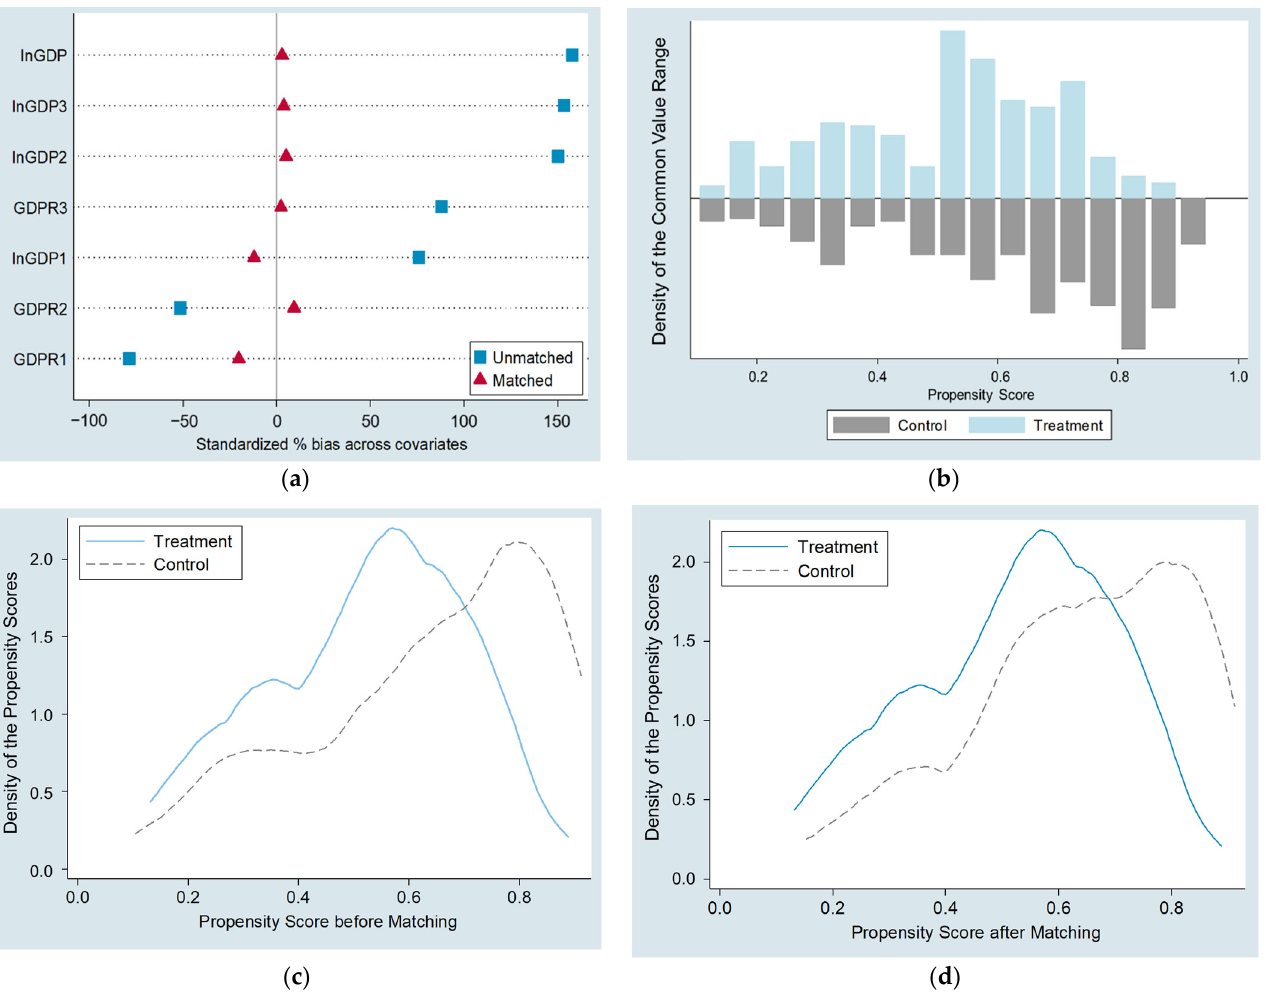
Figure 4. Results of the Propensity Score Matching (PSM). ( a ) Standardized bias across covariates; ( b ) common value range density of treatment and control groups; ( c , d ) density for treatment and control groups before and after the PSM, respectively. The grey line in ( a ) is the zero value of the standardized bias across covariates. Table 4. Regression results of the PSM ‐ DID estimation.